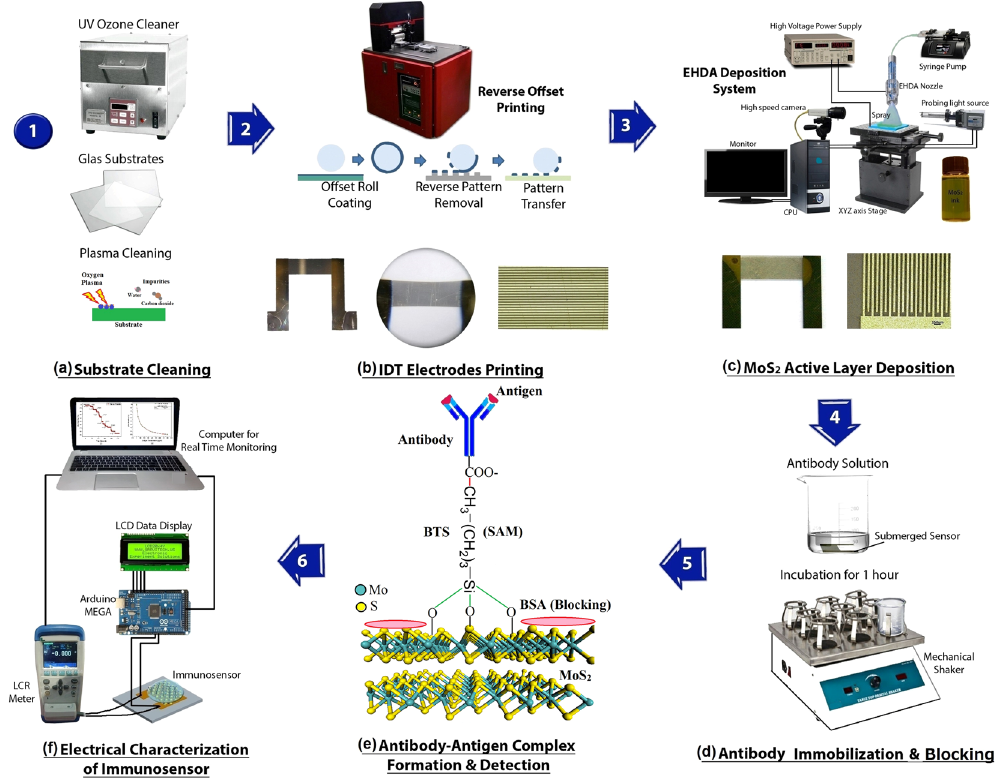
Figure 8. Process flow diagram of sensors fabrication and characterization. ( a ) Substrate cleaning by plasma, ( b ) Electrode fabrication by reverse offset printing, ( c ) MoS 2 active layer deposition by EHDA, ( d ) Antibody immobilization and blocking, ( e ) Antibody-antigen complex, and ( f ) Sensors’ electrical